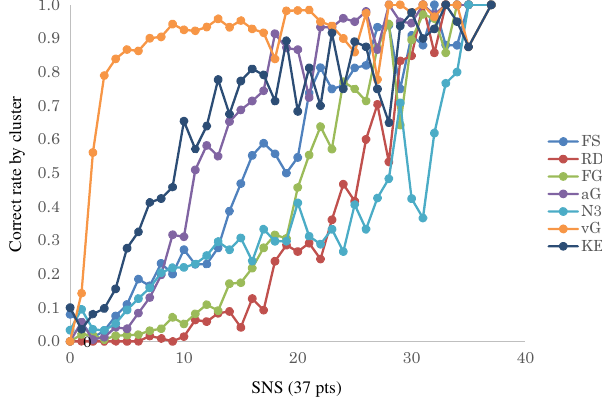
FIG. 3. The average difficulty index in each cluster with respect to the SNS. The values in the FS cluster correlate linearly to the SNS.